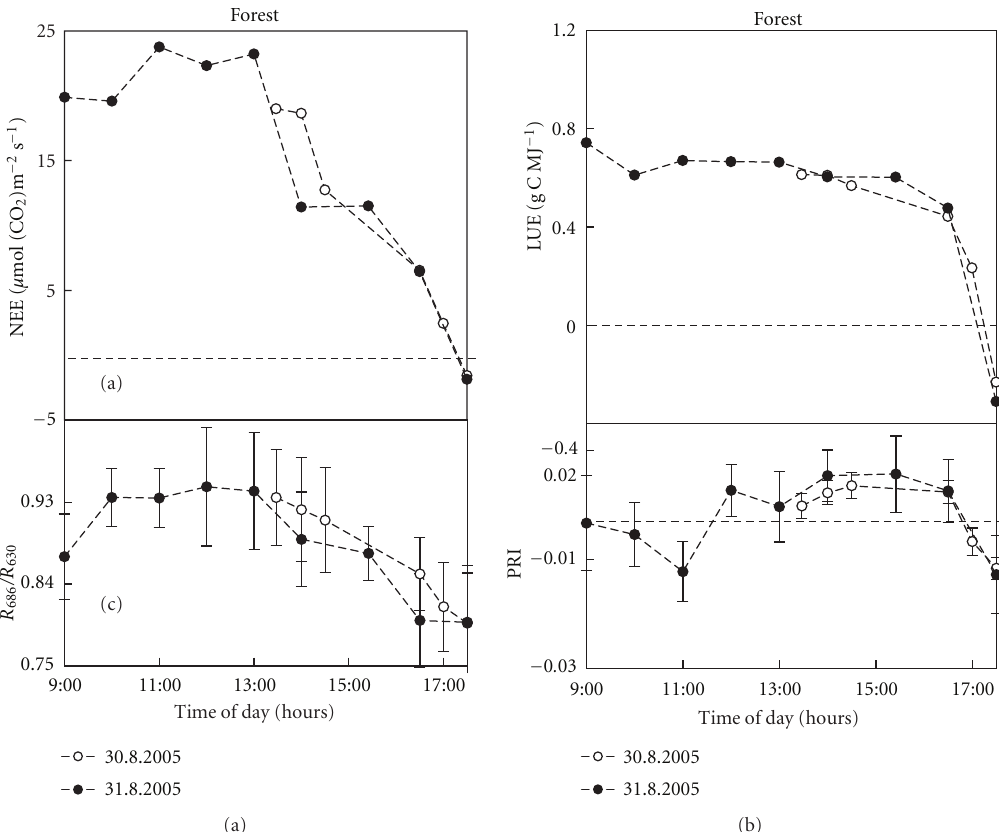
Figure 5: Daily courses of calculated net ecosystem exchange of CO 2 (NEE a) and radiation use e ffi ciency (LUE b) in forest ecosystem during two consecutive days with corresponding daily courses of R 686 / R 630 (c) and Physiological Reflectance Index (PRI, ( R 532 − R 570 )/( R 532 + R 570 )) (d) vegetation indexes (VIs) measured via hyperspectral imaging sensor (AISA Eagle, Finland). Data dots of eddy-covariance parameters represent averages of half-hour measurements (a, b) and data dots of VIs (c, d) represent average of more than 400 000 image pixels (i.e., average of one image scan acquired in half and one hour intervals and error bars show ± s.d.). Dashed line shows zero value of the y